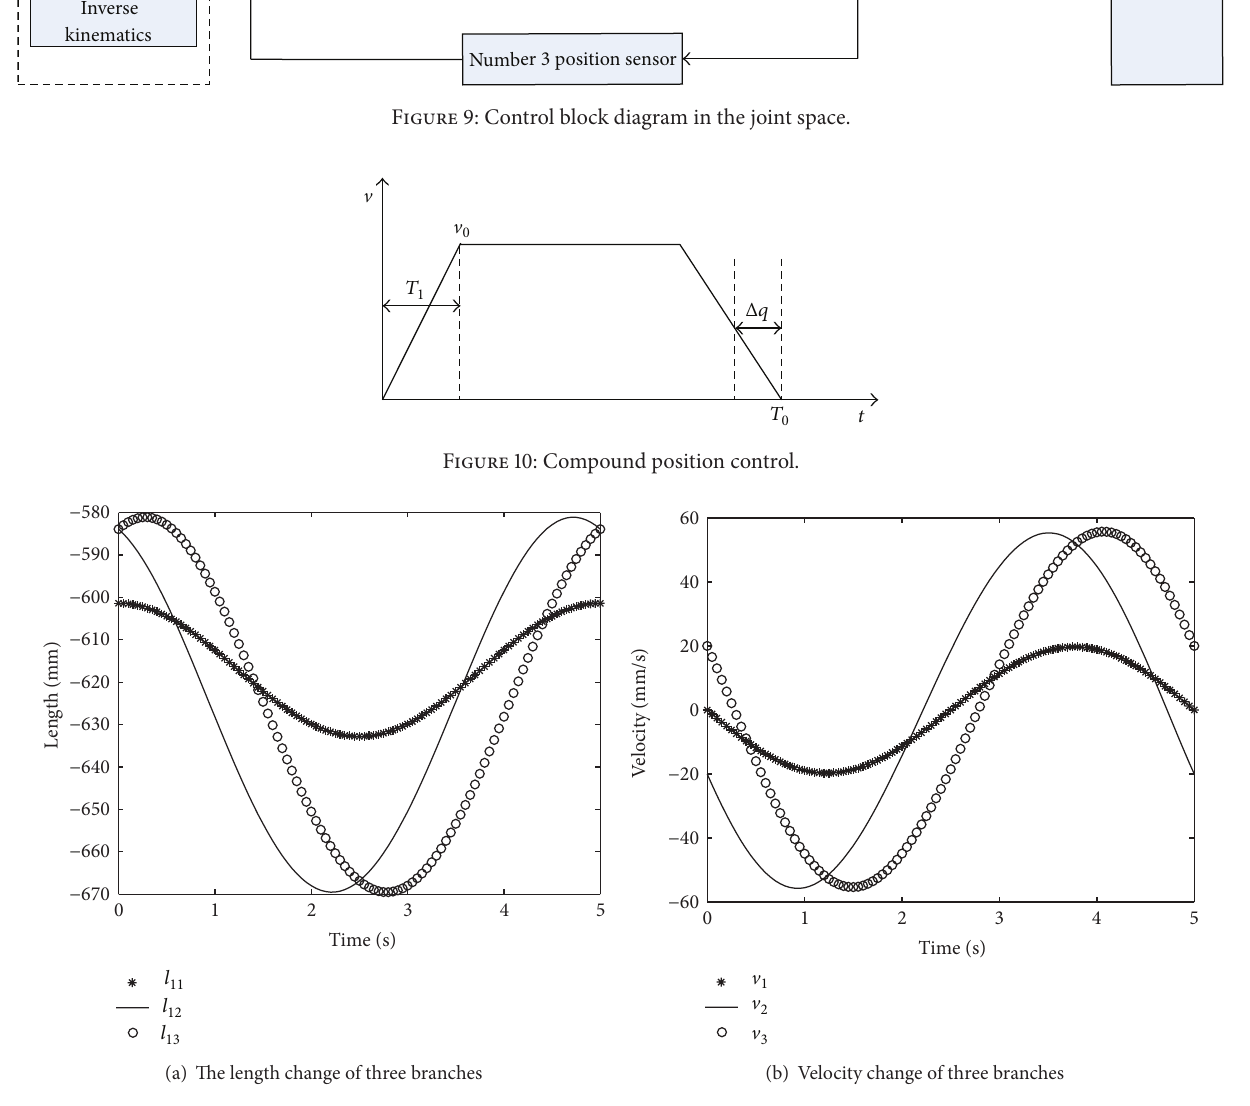
Figure 11: Inverse kinematics analysis of the leg